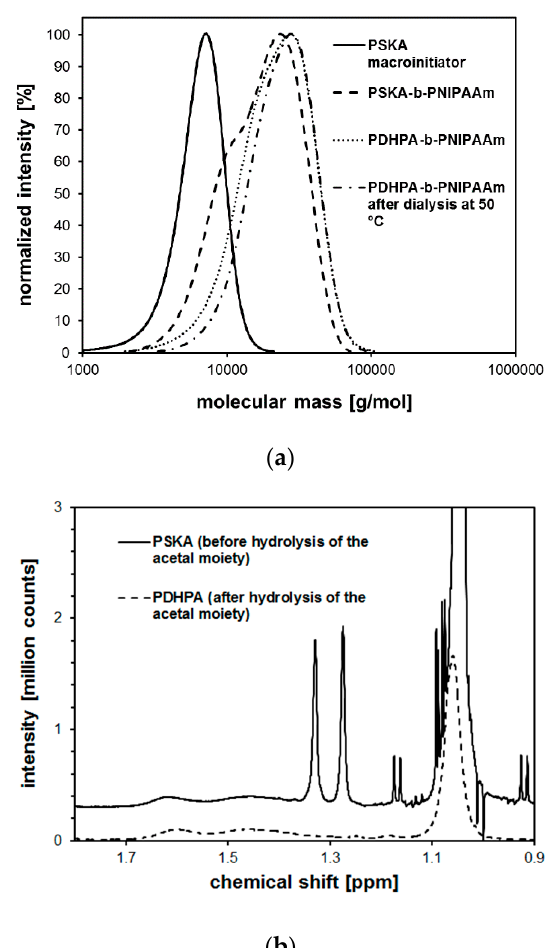
Figure 11. ( a ) Molecular mass distributions of the PSKA macroinitiator, the PSKA- b -PNIPAAm block copolymer, and the PDHPA- b -PNIPAAm block copolymer before and after dialysis at 50 °C as a result of SEC analysis; ( b ) high field region of 1 H-NMR spectra of PSKA and PDHPA confirming total acetal cleavage.